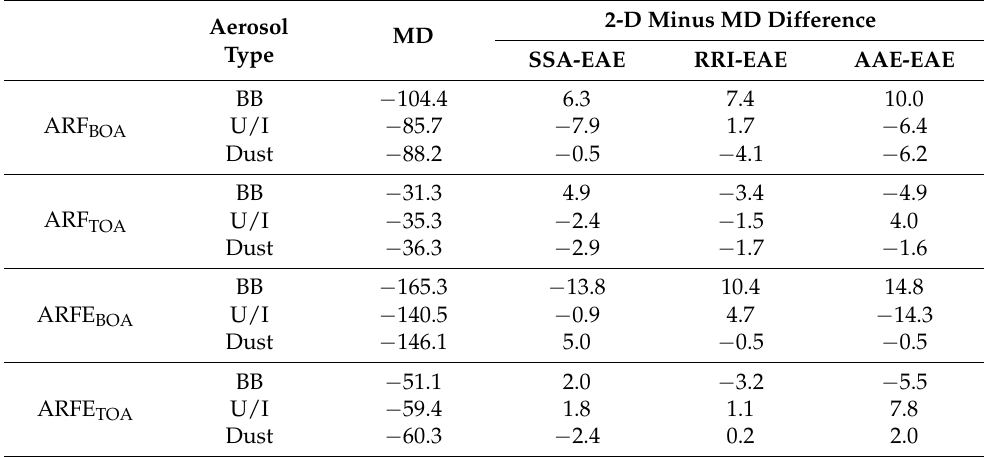
Table 6. Daily averaged ARF (unit: W/m 2 ) and ARFE (unit: W/m 2 /AOD 550nm ) for various types of aerosols from MD method as well as the 2-D minus MD results for the whole study